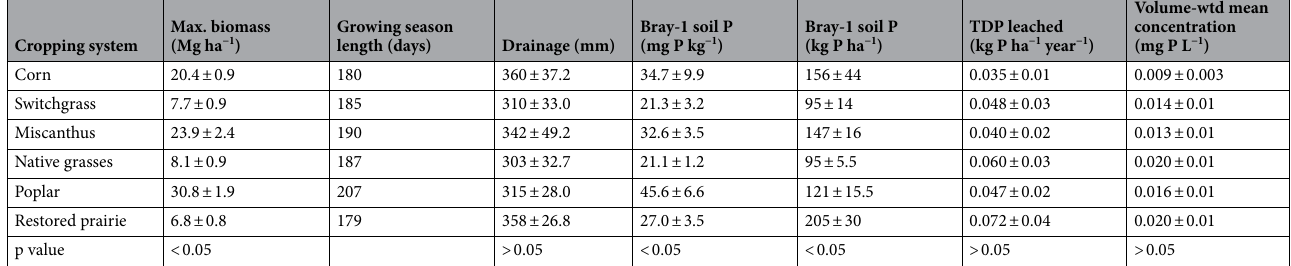
Table 3. Maximum aboveground biomass, growing season length, annual drainage, Bray-1 soil test P, total dissolved P (TDP) leaching rates, and volume-weighted mean P concentrations (means ± s.e.) across the seven crop-years (2009–2015) in each cropping system. The p values indicate which variables show significant differences among the